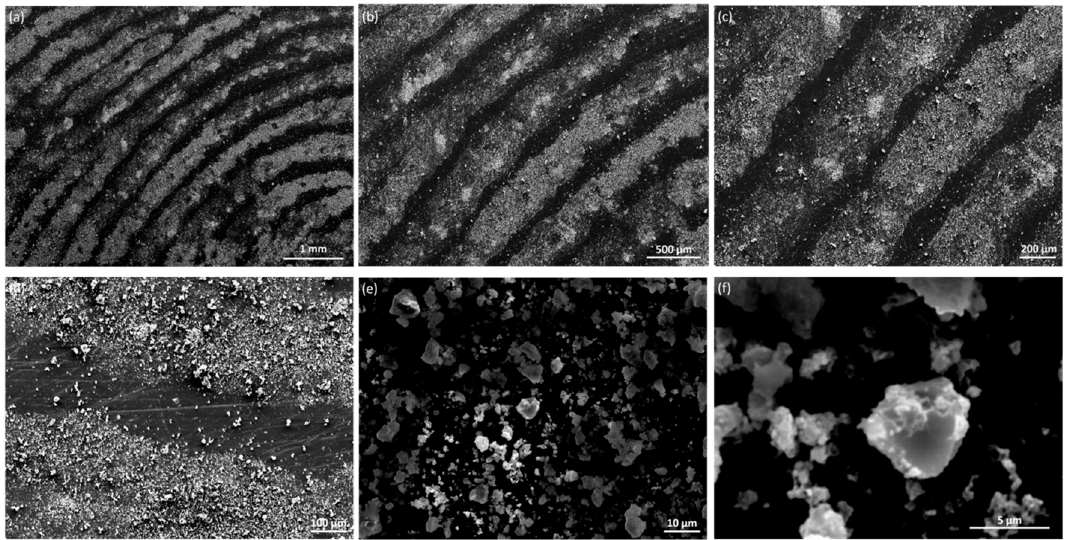
Figure 4. ( a – f ) SEM images of fingermarks developed with RHL/chalcone.